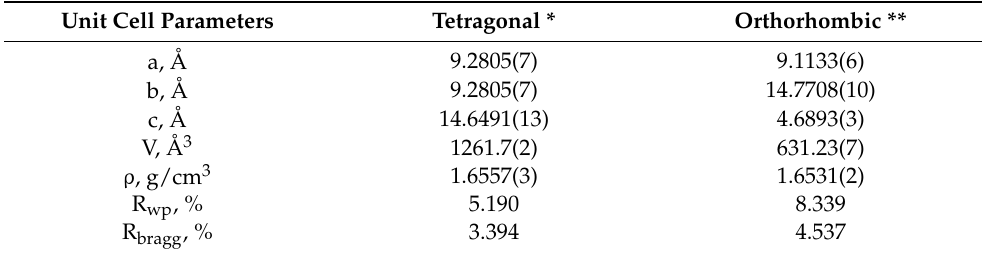
Table 1. Summary of the powder patterns depicted in Figure 1